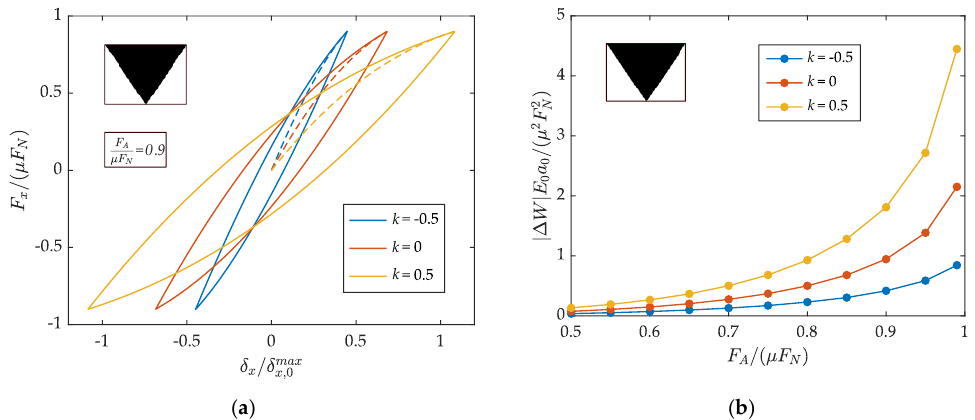
Figure 7. Hysteresis curve and energy dissipation of a conical indenter for various exponents of the elastic inhomogeneities 𝑘 : ( a ) Tangential force over the tangential displacement; ( b ) Energy dissipation over the traction ratio 𝐹 𝐴 . 𝜇𝐹 𝑁